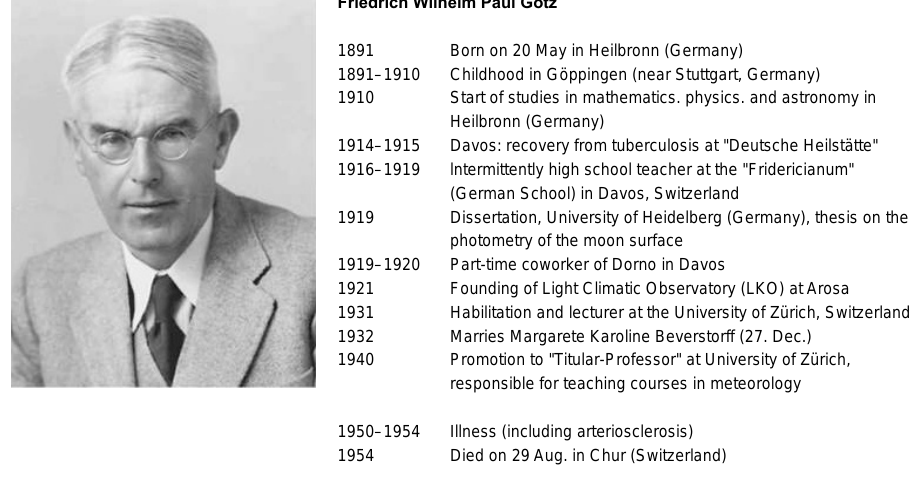
Götz obtained from the KVV Arosa was rather modest and he later secured additional regular funding from the Chur-Arosa railway company, the Arosa municipality, and the canton of Grisons (for more detail see Staehelin and Viatte, 2018). The LKS measurements were made on the roof of the Inner-Arosa Sanatorium, where the “Grand Hotel Tschuggen” is now lo- cated (see Fig. 2). For the first few years Götz was able to borrow an instru- ment from Dorno (who was based in Davos, see Sect.